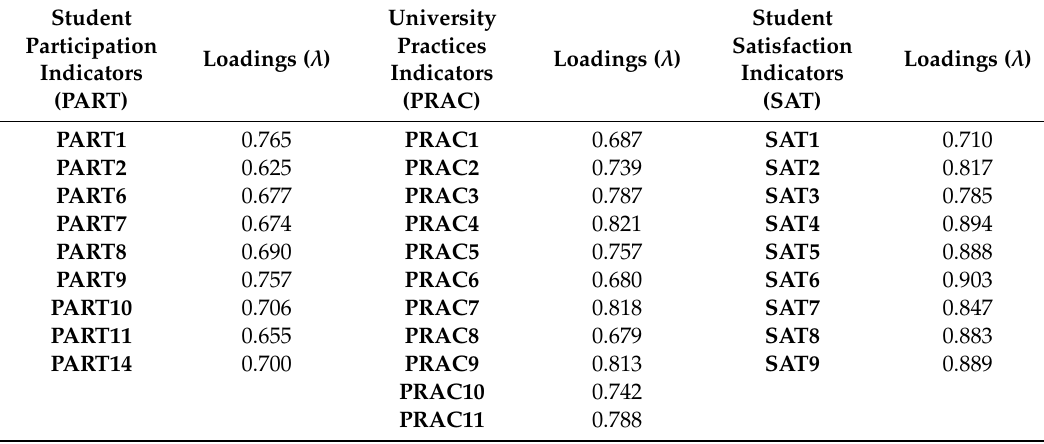
Table 5. Individual reliability of items for all constructs.